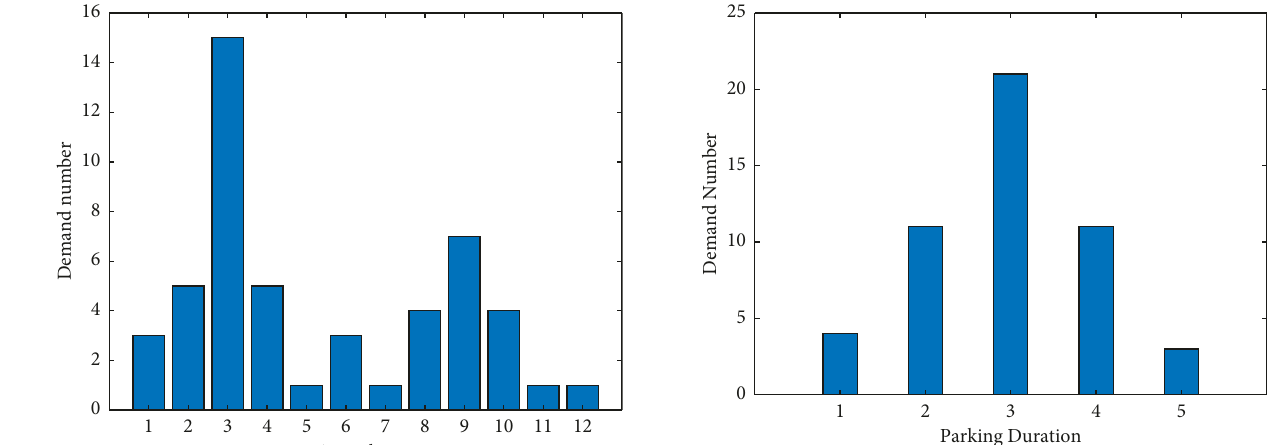
Figure 9: Parking duration distribution.